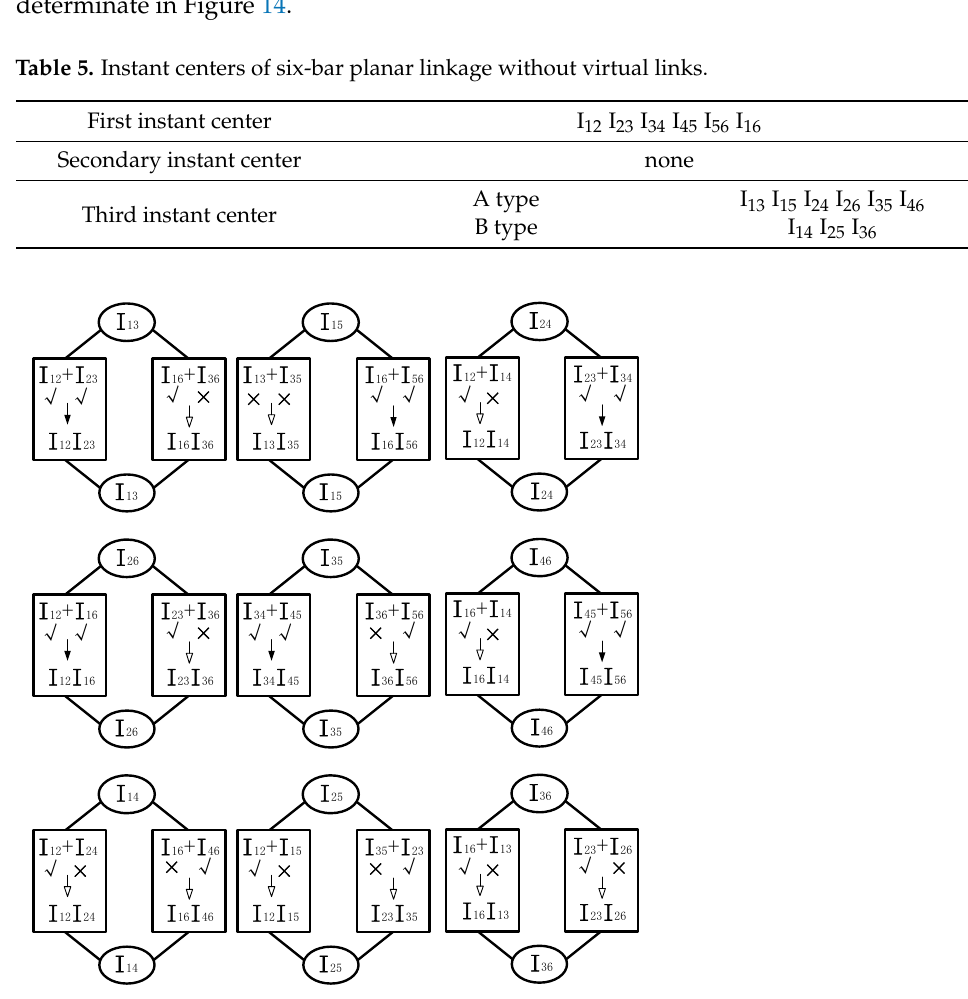
Figure 14. The instant center identification process graph of six-bar planar linkage without virtual links.